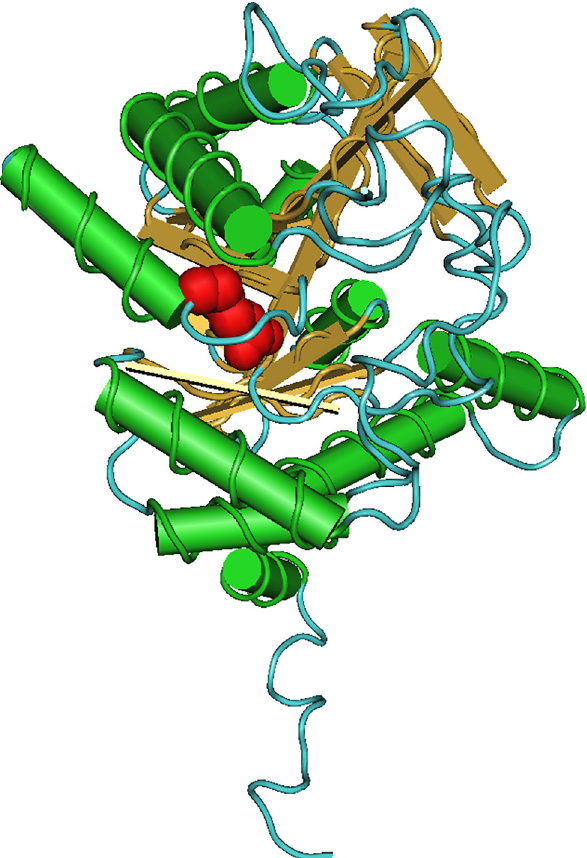
Fig 2. Three-dimensional structure of the ALAD protein. Monomeric structure of the ALAD protein. The red color indicates the position of the arginine 174. The amino acid is completely buried into the monomeric structure of the ALAD